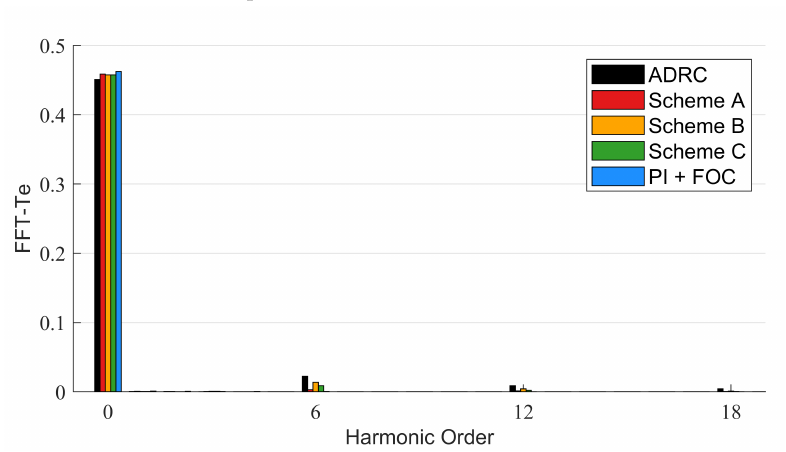
Figure 14. FFT of motor